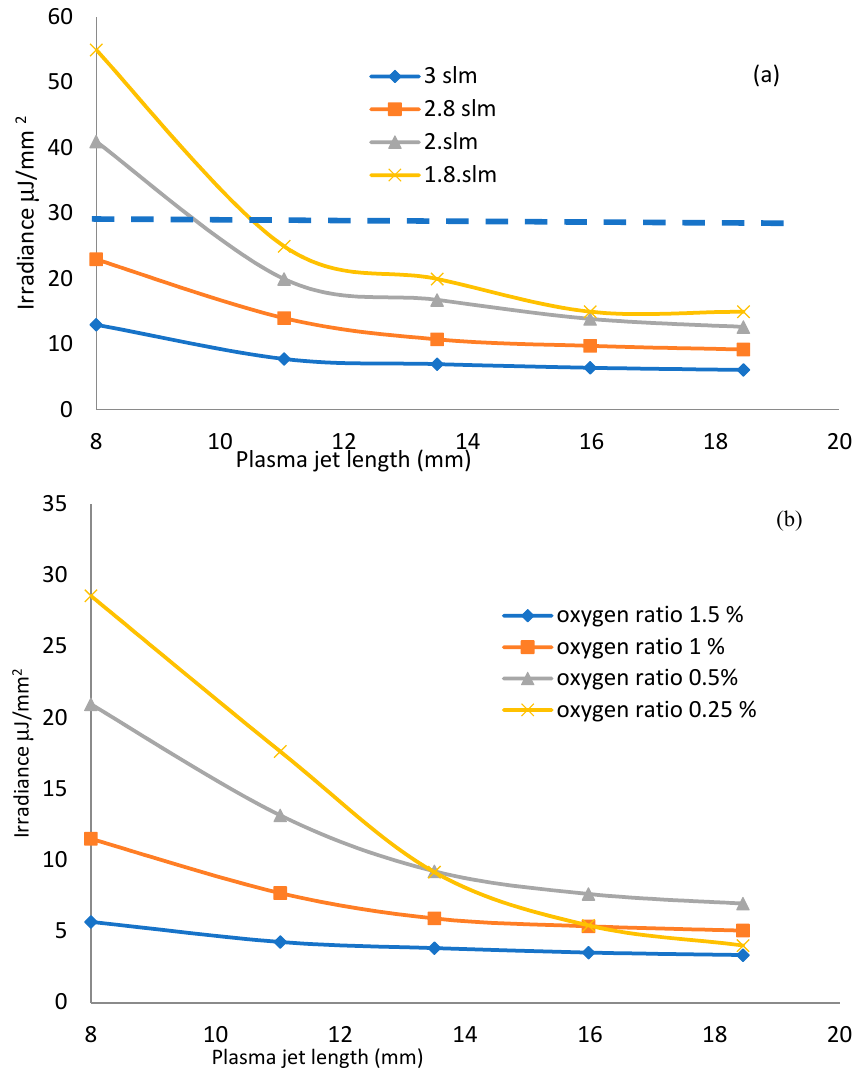
Figure 15. Dose rate of irradiance per unit area ( μ J/mm 2 ) of plasma jet discharge as a function of plasma jet length ( a ) for argon discharge with different flow rates and ( b ) for oxygen/argon admixture discharge for different oxygen ratios.